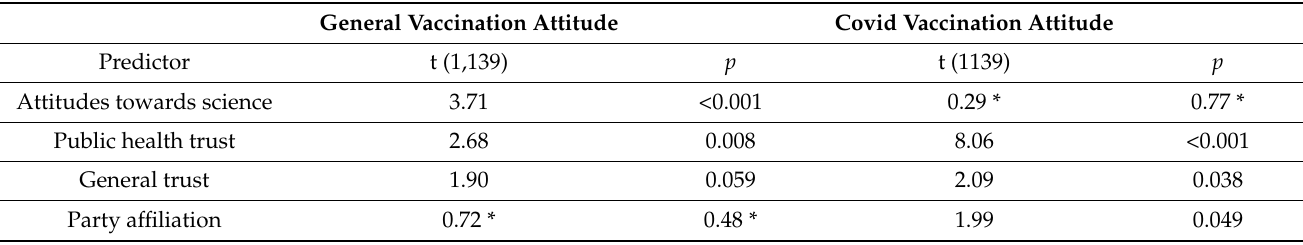
Table 7. Significant predictors of general and covid vaccination attitudes, multiple predictor model.